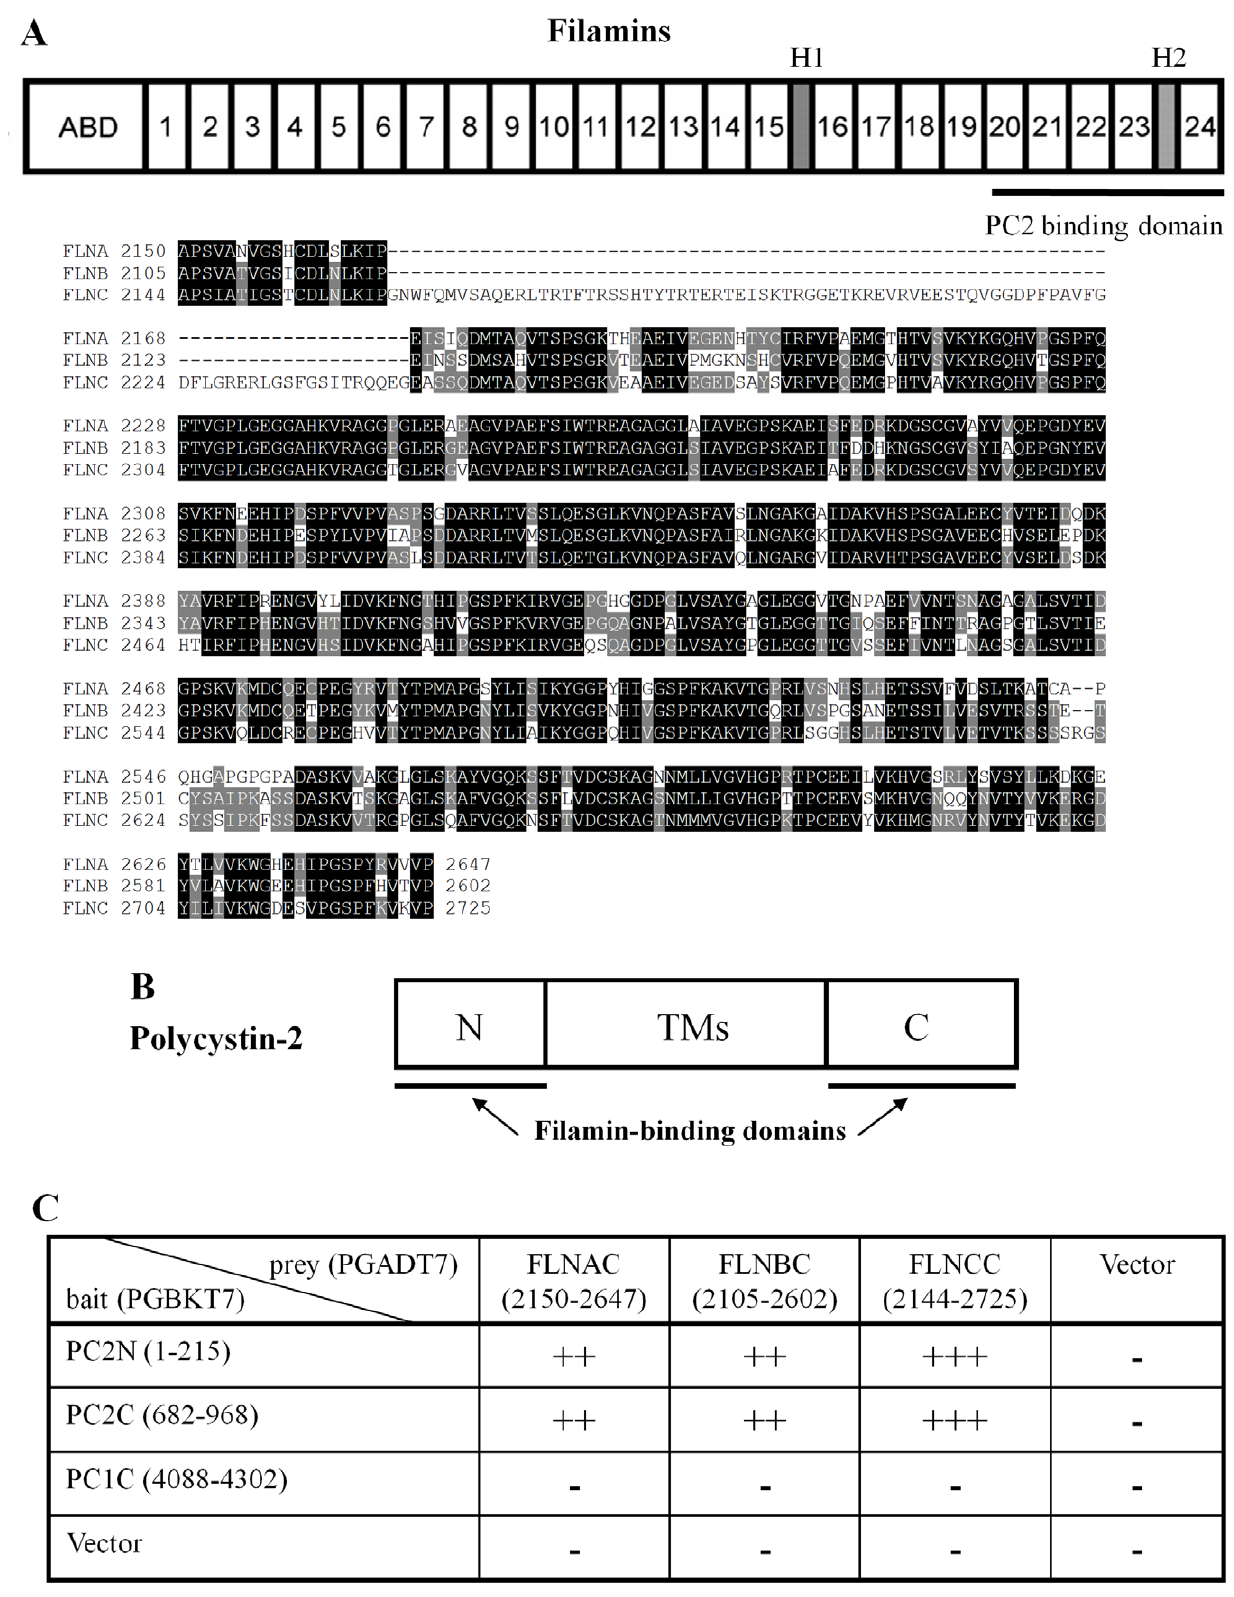
Figure 1. Structural domains and sequence of FLNs and PC2, and their interaction identified by yeast two-hybrid assay. ( A ) Upper panel, domain structure of human filamins (FLNs), FLNA, FLNB and FLNC, and sequence alignment. FLNs share common features such as the N- terminal actin-binding domain (ABD) and a semi-rigid rod composed of 24 Ig-like repeats ( , 96 aa each) interrupted by two short flexible hinges (H1